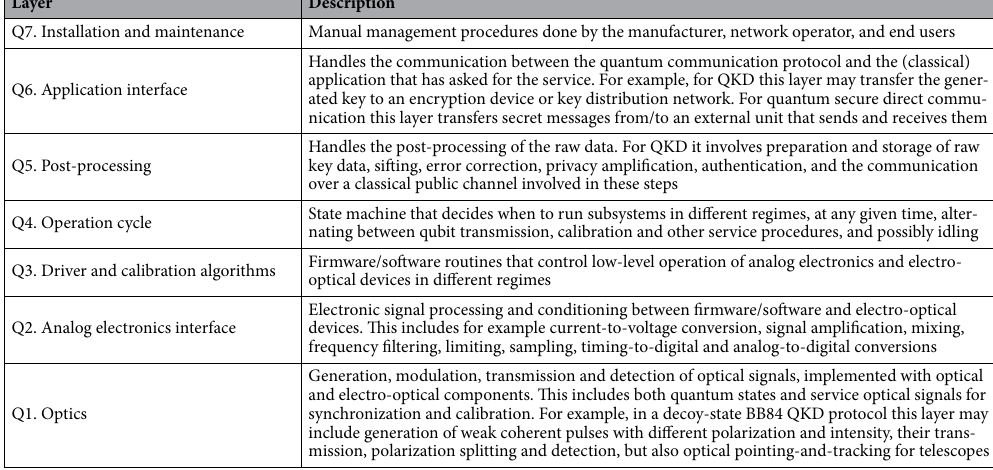
Table 1. Implementation layers in a quantum communication